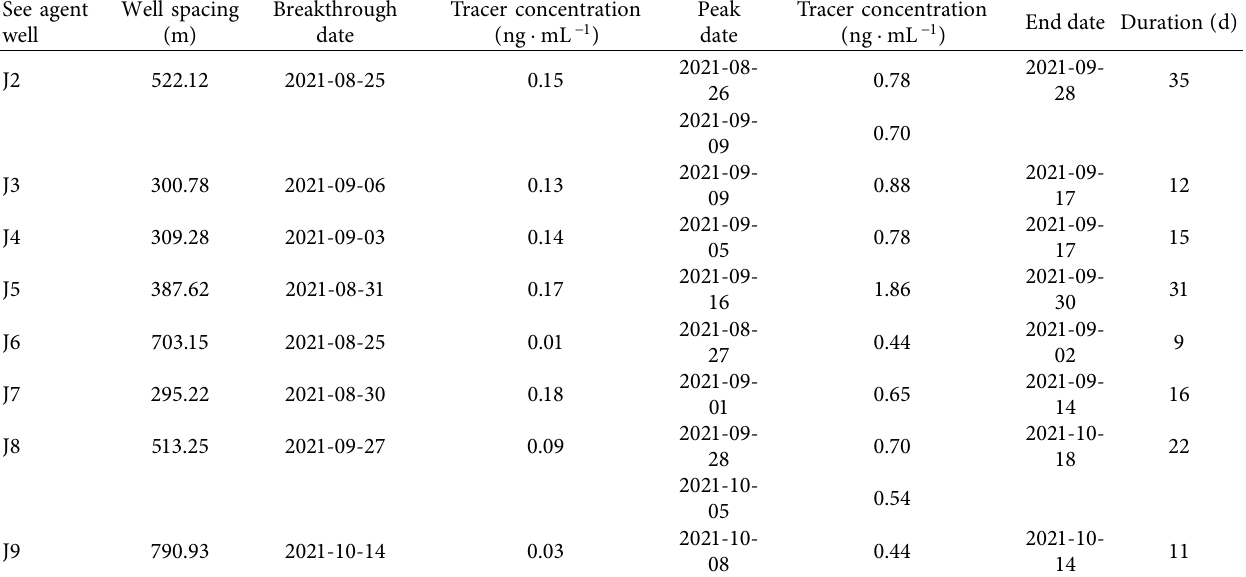
Table 3: Tracer production performance of tracer wells.